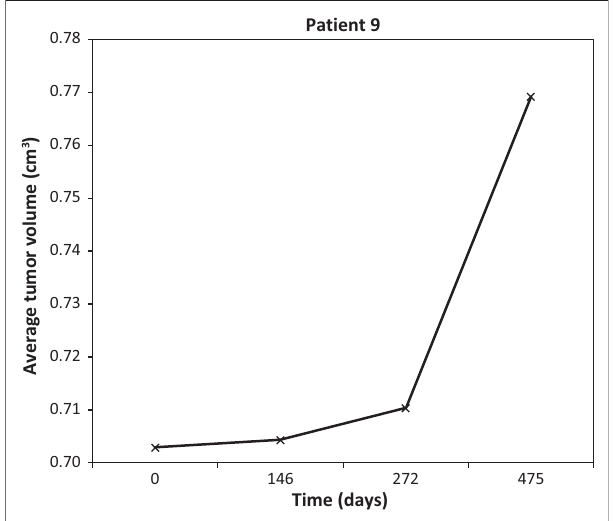
FIGURE 4: Macroadenoma growth observed in a 25-year-old female.